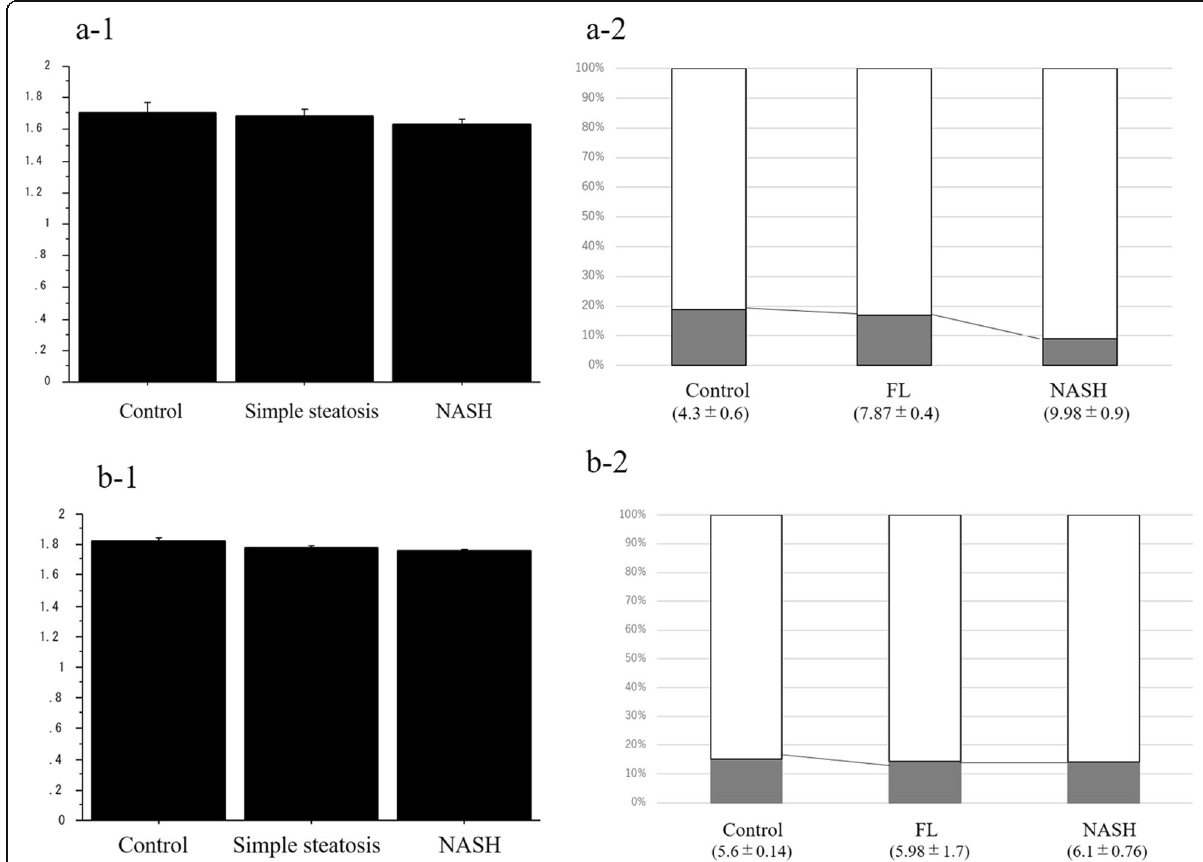
Fig. 2 Acoustic impedance analysis. a Mouse. ( a-1 ) Liver sample: the acoustic impedance (× 10 6 kg/m 2 /s) showed a gradual decrease from control (median 1.715, IQR 0.06), SS (median 1.68, IQR 0.05), to NASH (median 1.635, IQR 0.025), showing differences between control and SS ( p = 0.554), control and NASH ( p = 0.039), and SS and NASH ( p = 0.113). ( a-2 ) FFA in the liver: the ratio of sum of percentage composition of FFAs between the low-impedance group and the high-impedance group showed gradual increases from control (median 4.45, IQR 0.65; 3.58 – 4.87), SS (median 7.92, IQR 0.322; 7.23 – 8.39), to NASH (median 9.9, IQR 0.73; 8.94 – 11.2), with significant differences between control and SS ( p = 0.0002), control and NASH ( p < 0.001), and SS and NASH ( p = 0.003). White, low- impedance group; gray, high-impedance group. Data are presented as mean and standard deviation. b Human liver sample. ( b-1 ) Liver sample: the acoustic impedance (× 10 6 kg/m 2 /s) showed gradual decrease from control (median 1.825, IQR 0.015), SS (median 1.788, IQR 0.0045), to NASH (median 1.76, IQR 0.015), showing differences between control and SS ( p = 0.023), control and NASH ( p = 0.003), and SS and NASH ( p = 0.050). ( b-2 ) Free fatty acids in the liver: the ratio of sum of percentage composition of FFAs between the low-impedance group and the high-impedance group showed a gradual increase from control (median 5.7, IQR 0.012; 5.53 – 5.73), SS (median 5.9, IQR 0.0029; 4.23 – 7.75), and NASH (median 6.2, IQR 0.0021; 5.3 – 6.8). However, there were no significant differences between control and SS ( p = 0.758), control and NASH ( p = 0.671), and SS and NASH ( p = 0.893). White, low-impedance group; gray, high-impedance group. Data are presented as mean and standard deviation. FFA Free fatty acid, IQR Interquartile range, NASH Nonalcoholic steatohepatitis, SS Simple